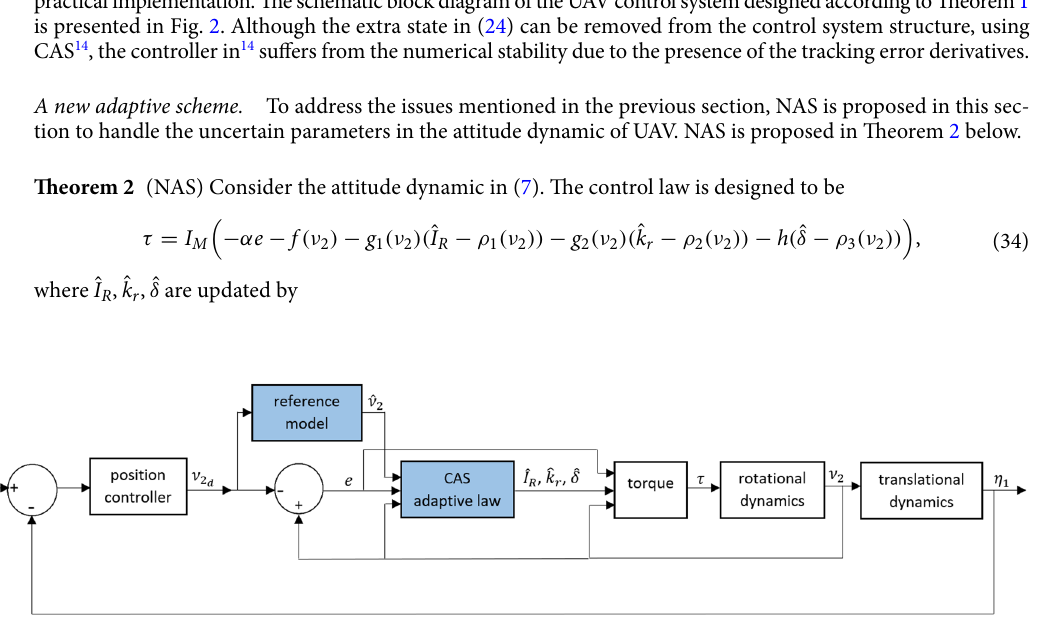
Figure 2. The control system design for a 6-DOF UAV using